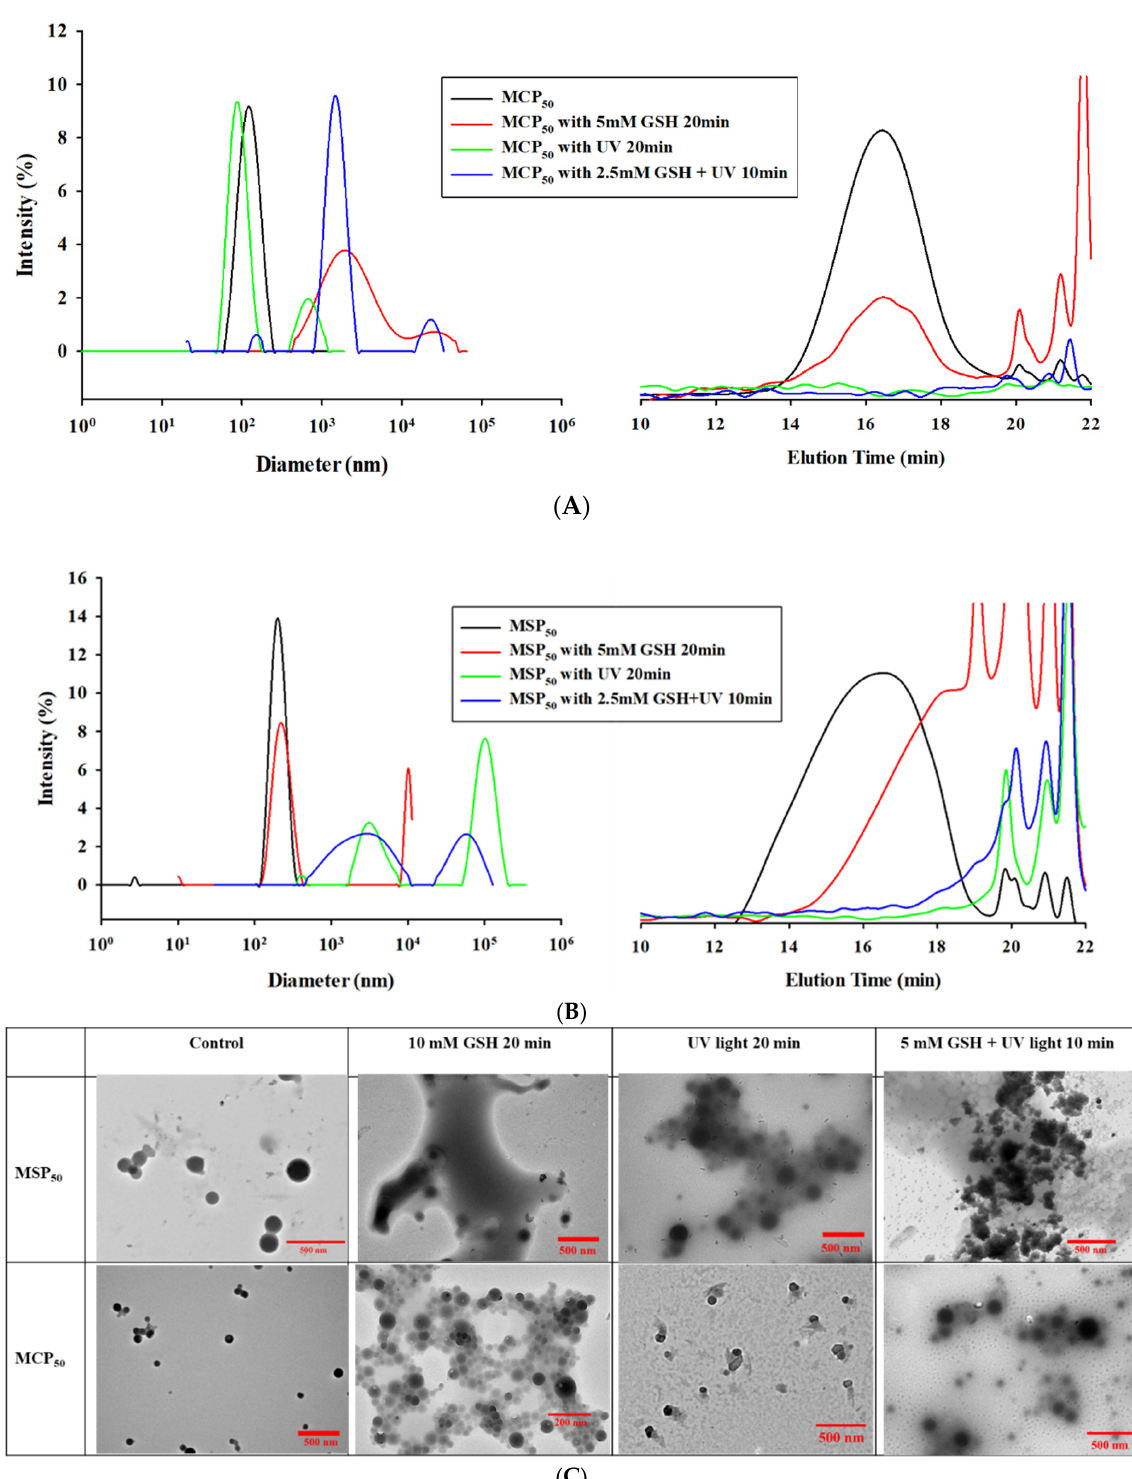
Figure 3. Dynamic light scattering (DLS) and size exclusion chromatography (SEC) profiles of mPEG-CC-pONBMA (MCP 50 ) ( A ) and mPEG-SS-pONBMA (MSP 50 ) ( B ) and transmission electron microscopic (TEM) images of MCP 50 and MSP 50 after indicated treatments ( C ).